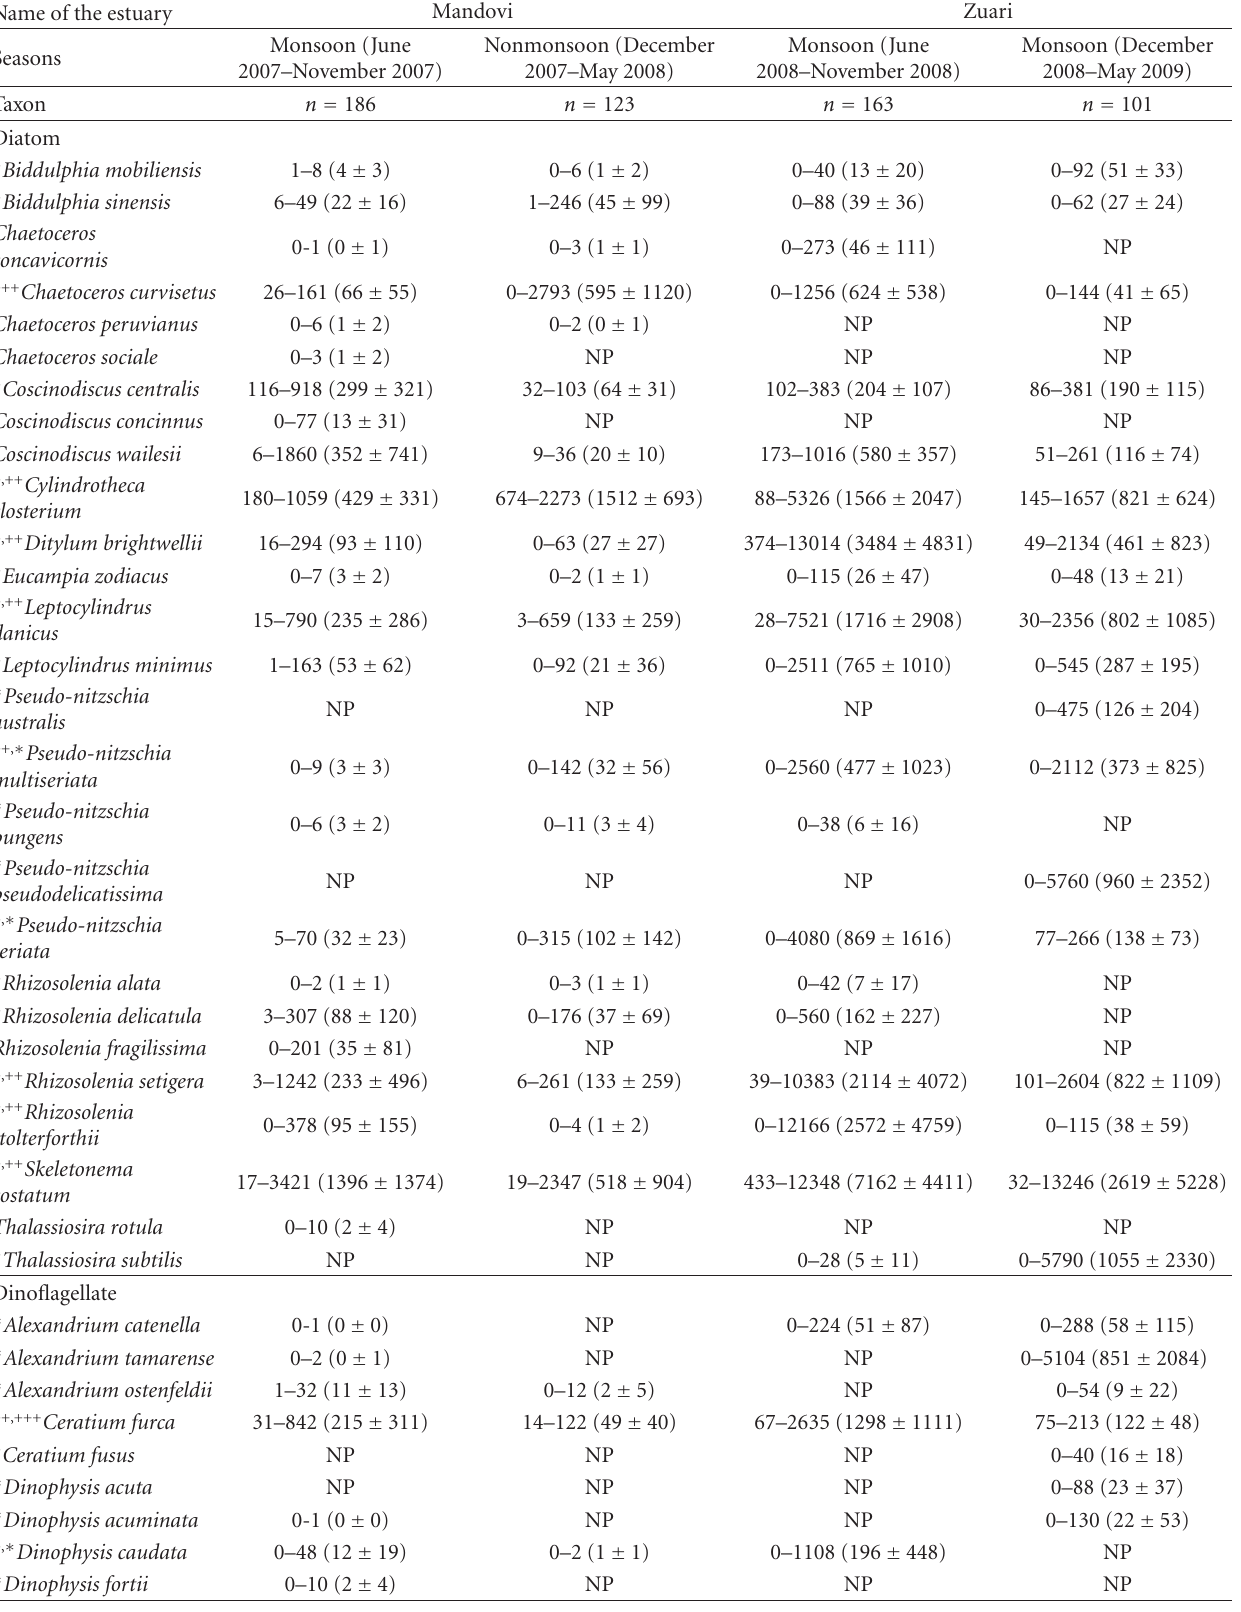
Table 1: List of potentially harmful and toxic species ranges of their cell counts L − 1 during monsoon and nonmonsoon period in Mandovi and Zuari estuaries of